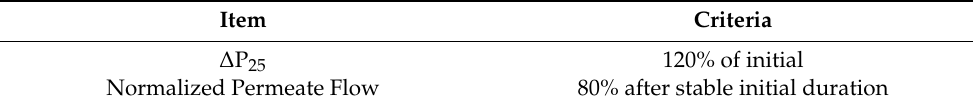
Table 3. Criteria of clean in place (CIP).